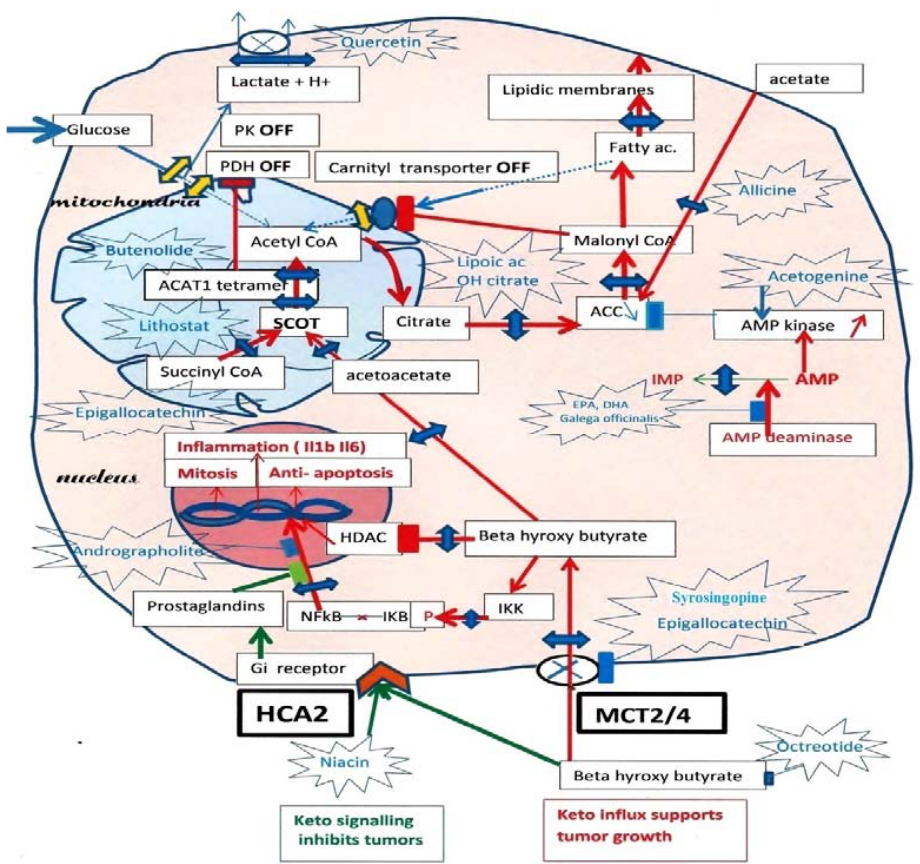
Figure 1. Ketolytic dependent tumor cells. Inhibitions by phosphorylation, of Pyruvate kinase PK M2, and Pyruvate dehydrogenase PDH, cut the glycolytic supply of acetyl-CoA to mitochondria, lactic acid release occurs through MCT monocarboxylate transporters. Moreover, an acetylation of PDH by ACAT1 thiolase further increases the inhibition of PDH. Since tumors must synthesize fatty acid to create new membranes, this automatically turns off the fatty acid mitochondrial carnityl transporter and the fatty acid supply of acetyl-CoA. The carnityl transporter is inhibited by malonyl-CoA, the product of Acetyl CoA carboxylase (ACC), starting the lipogenic pathway in the cytosol. Hence, ketone bodies and beta-hydroxybutyrate, (BHB) become an essential source of acetyl-CoA in tumors, via SCOT the specific ketolytic enzyme and ACAT1. Then, citrate exits the mitochondria and feeds lipogenesis via ATP citrate lyase (ACL) and acetyl-CoA carboxylase (ACC). By blocking the MCT transporters with indicated compounds, one would affect the lactate release, the influx of beta ‐ hydroxybutyrate (BHB) and the supply of acetoacetate to SCOT. We indicate possible inhibitors for SCOT: Lithostat or other Siderophores, Ferrichrome, Phycocyanin, Febrifugine or even Melatonin. As for ACT1, Butenolides, vitamin C and others are indicated; this should starve the tumor. We suggest inhibiting the citrate condensation and supply to the lipogenic pathway using lipoic acid and hydroxycitrate, as indicated. Moreover, Allicine would cut the direct conversion of acetate into acetyl ‐ CoA in the cytosol. An essential key is that AMP kinase will inhibit ACC, which merits stimulation by acetogenin, and to inhibit AMP deaminase with Docosahexaenoic acid (DHA) or Galega officinalis, or metformin. By inhibiting the entry of BHB, one also stops the stimulation of NFkB ‐ mediated transcription, a hallmark of cancer, and cancels the inhibition of histone deacetylase (HDAC) caused by BHB. Upstream of ketolysis, one may use octreotide (a somatostatin analog) to decrease the ketogenic supply. There is, however, a paradox, since the signaling action of extracellular BHB on HCA2, a Gi coupled receptor, is to preserve (it inhibits NFkB transcription). A prostaglandin messenger is involved; it can be strengthened with Andrographolite. Niacin is another agonist for HCA2, which may help when using octreotide for decreasing ketogenesis. Green arrows: HCA2 signaling. Red arrows: BHB influx through MCT and effects.